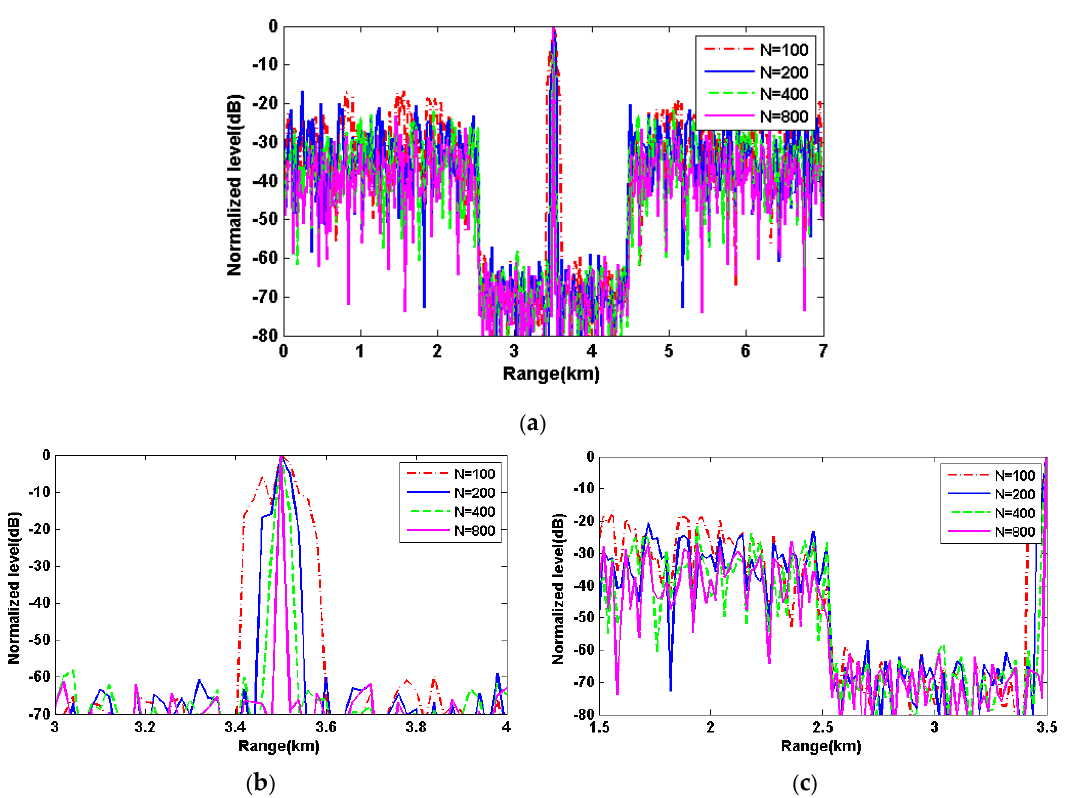
Figure 4. ( a ) The matched filter results versus ranges for the PeWISL sequences with sequence length 100, 200, 400, and 800, respectively; ( b ) the details of mainlobes with different sequence lengths; and ( c ) the details of sidelobes in the range interval [ 1.5,3.5 ]